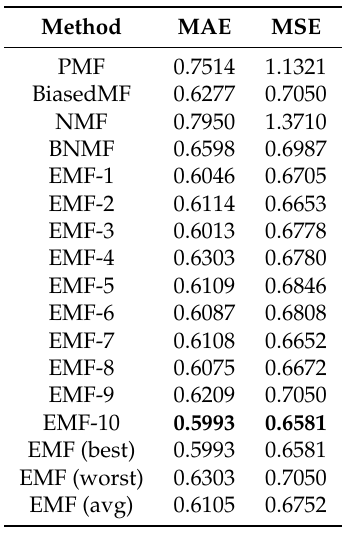
Figure 2. Tree representation of the best individual ( EMF-4 ) achieved for the MovieLens dataset. The correspondence between node symbols and operators are defined in Table 1. Table 4. MAE and MSE in predictions for FilmTrust